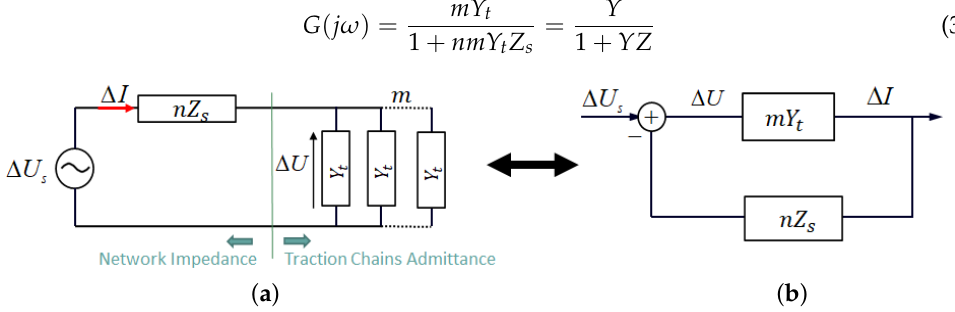
Figure 3. Closed loop system equivalence of small-signal model for n network impedance units and m traction chains. ( a ) Railway traction system small-signal model, ( b ) closed loop